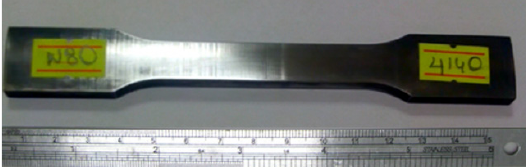
Figure 2. Tensile test